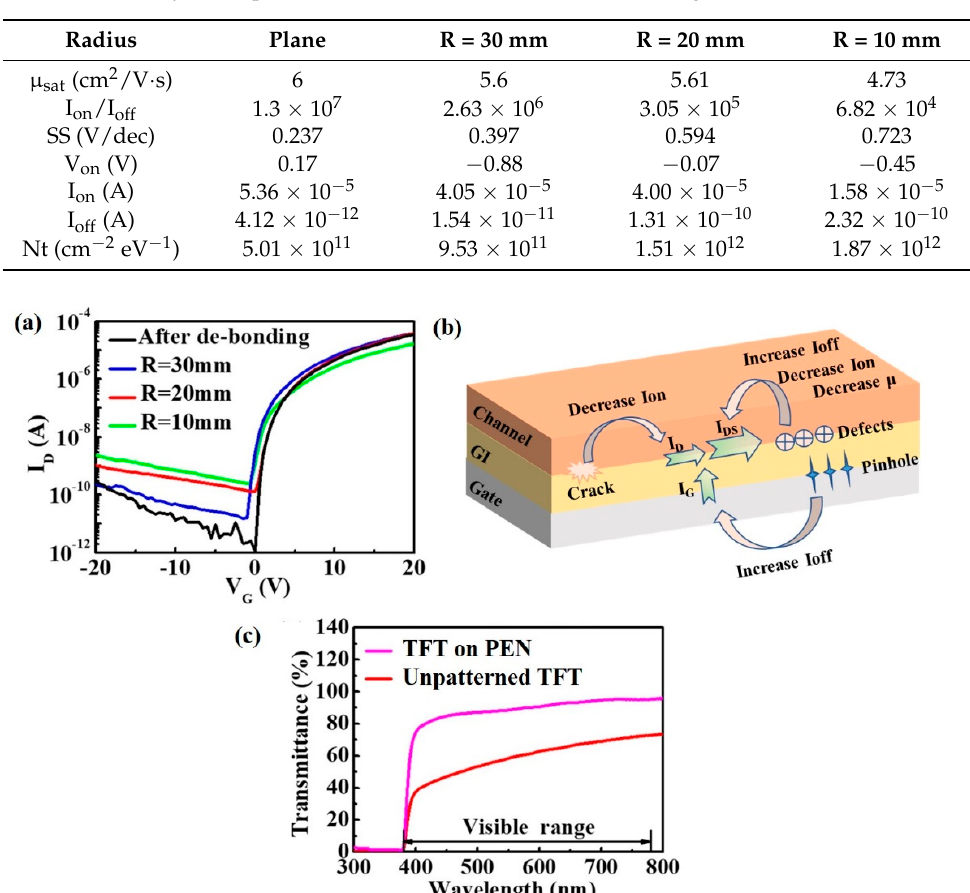
Figure 5. ( a ) Bending test of the flexible VL-TFT, ( b ) schematic diagram of TFT performance degradation under bending, ( c ) transmittance spectra in the wavelength range of 300~800 nm for the flexible TFT on PEN and unpatterned TFT. Table 1. Summary of the performance of the flexible TFT after bending.